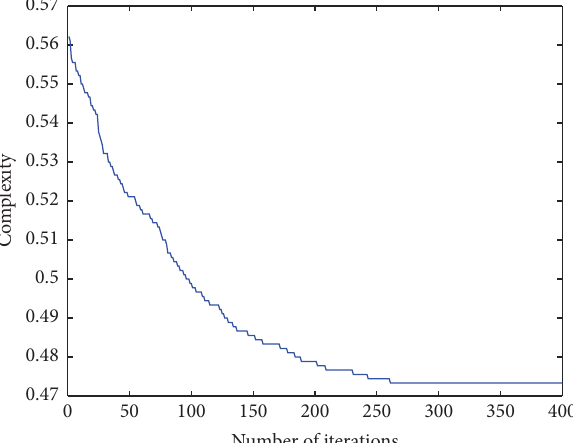
Figure 16: 20:00 to 21:00 time period complexity optimization